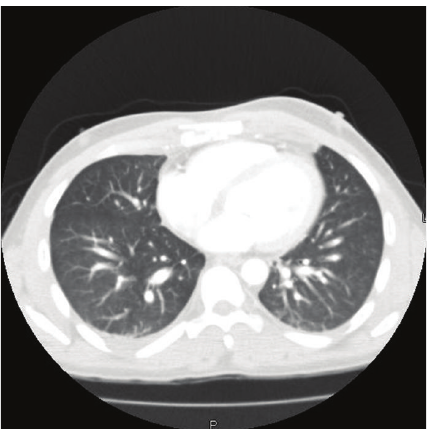
Figure 1: Chest CT revealing a sternal fracture and a small subster- nal hematoma.